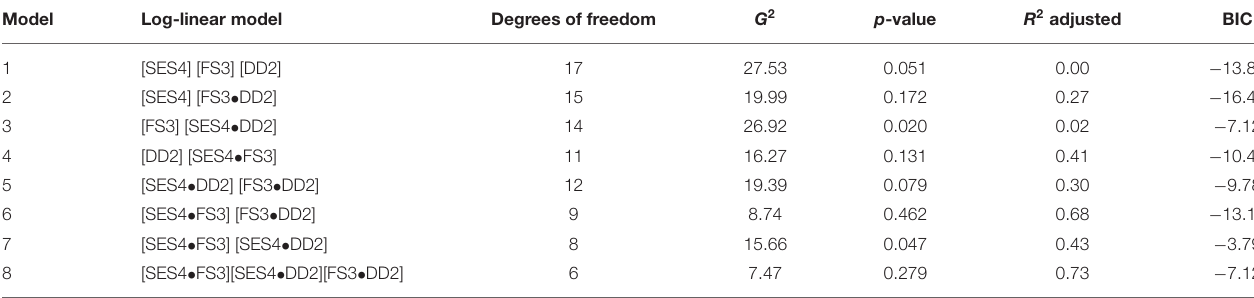
TABLE 4 | Log-linear models adjusted to explain the relationship structure among SES4, FS3, and DD2. Model Log-linear model